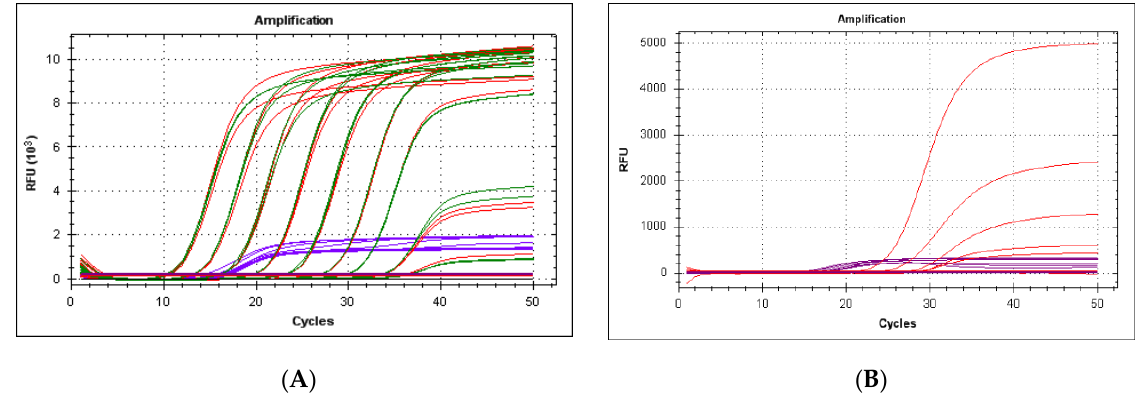
Figure 4. ( A ) Amplification of LeHV-5 gB gene in singleplex and duplex also for 18S rRNA gene (CY5 channel, purple curves). Red lines correspond to LeHV-5 amplification in singleplex reactions and green in duplex reactions. Horizontal black lines correspond to samples lacking amplification (2.1 × 10 − 1 and 2.1 × 10 − 2 copies per reaction) ( B ) Amplification of LeHV-5 (red curves) in duplex with the 18S rRNA gene (CY5 channel, purple curves), using field samples.